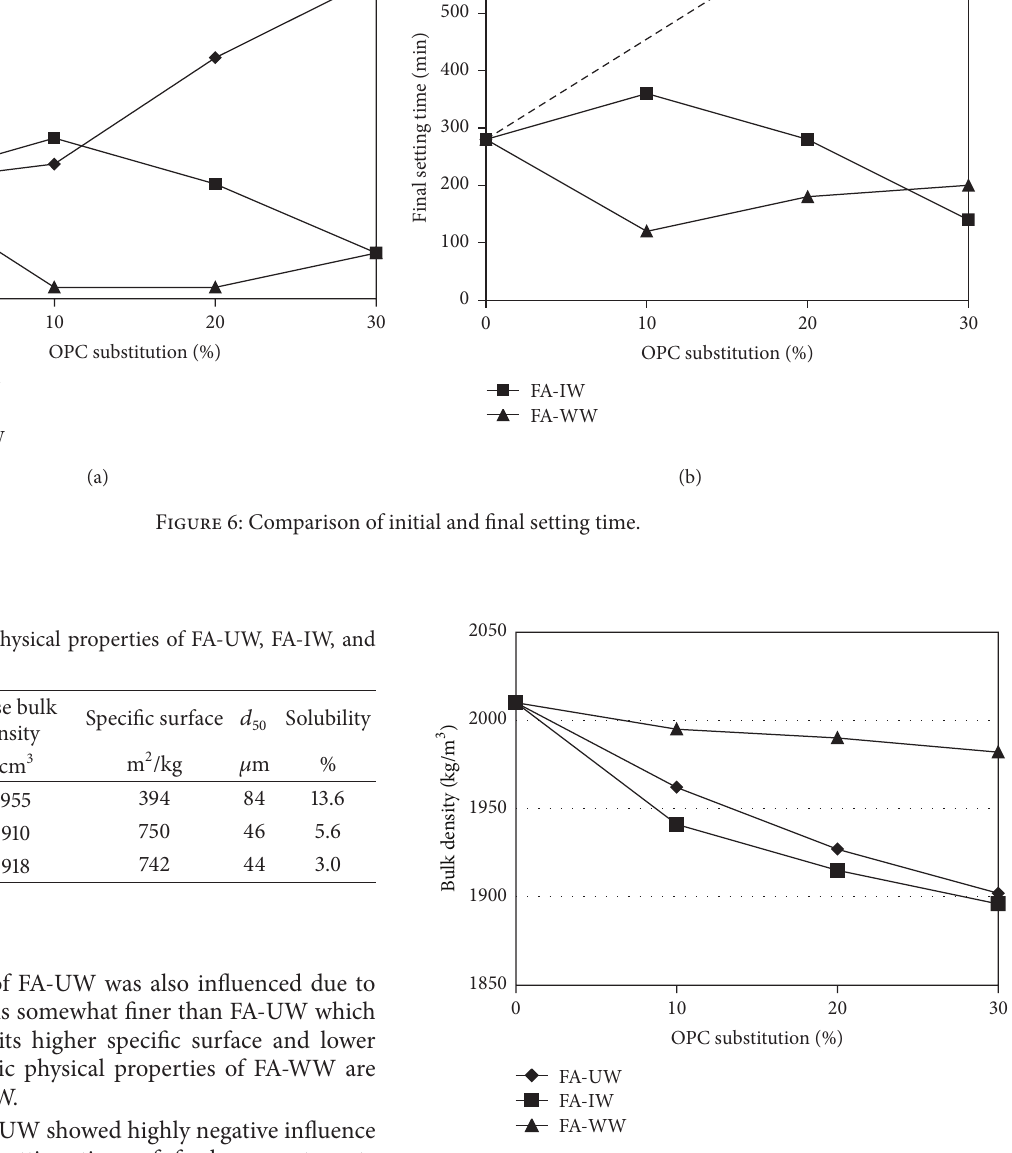
Figure 7: Influence of ashes on bulk density of